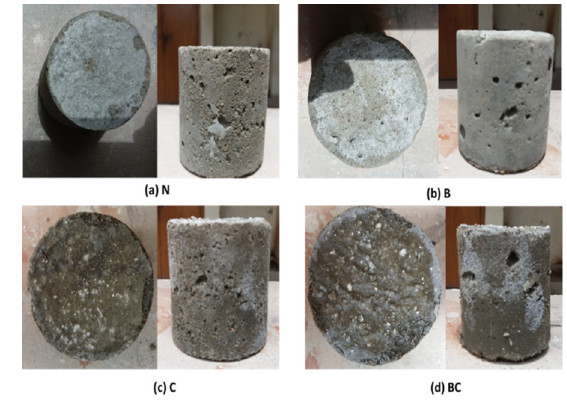
Fig. 5: Samples after removing from the Molds